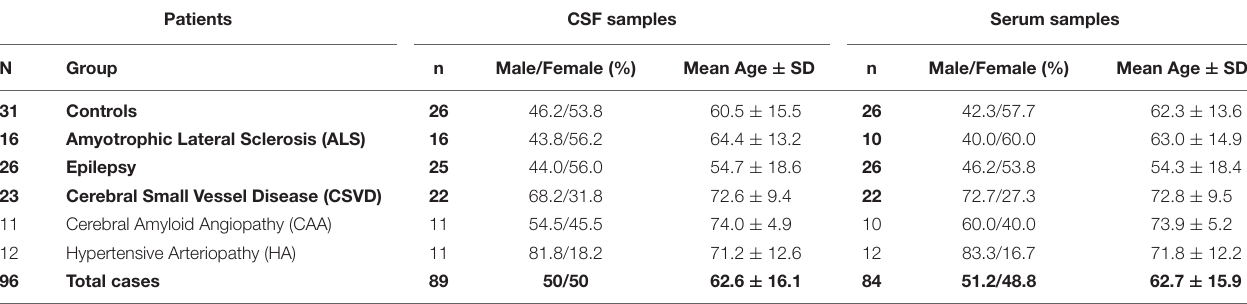
TABLE 1 | Demographic data of the patient